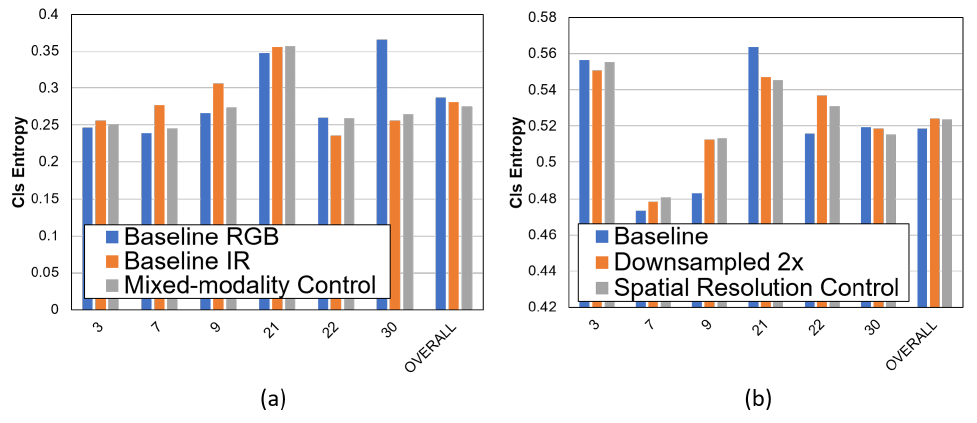
Figure 11. Uncertainty results on CAMEL Dataset. ( a ) With RGB only, IR only and Mixed-modality control ( b ) with RGB, 2 × downsampled and Spatial Resolution Control. Reprinted with permission from ref. [12]. Coprright 2020 IEEE.